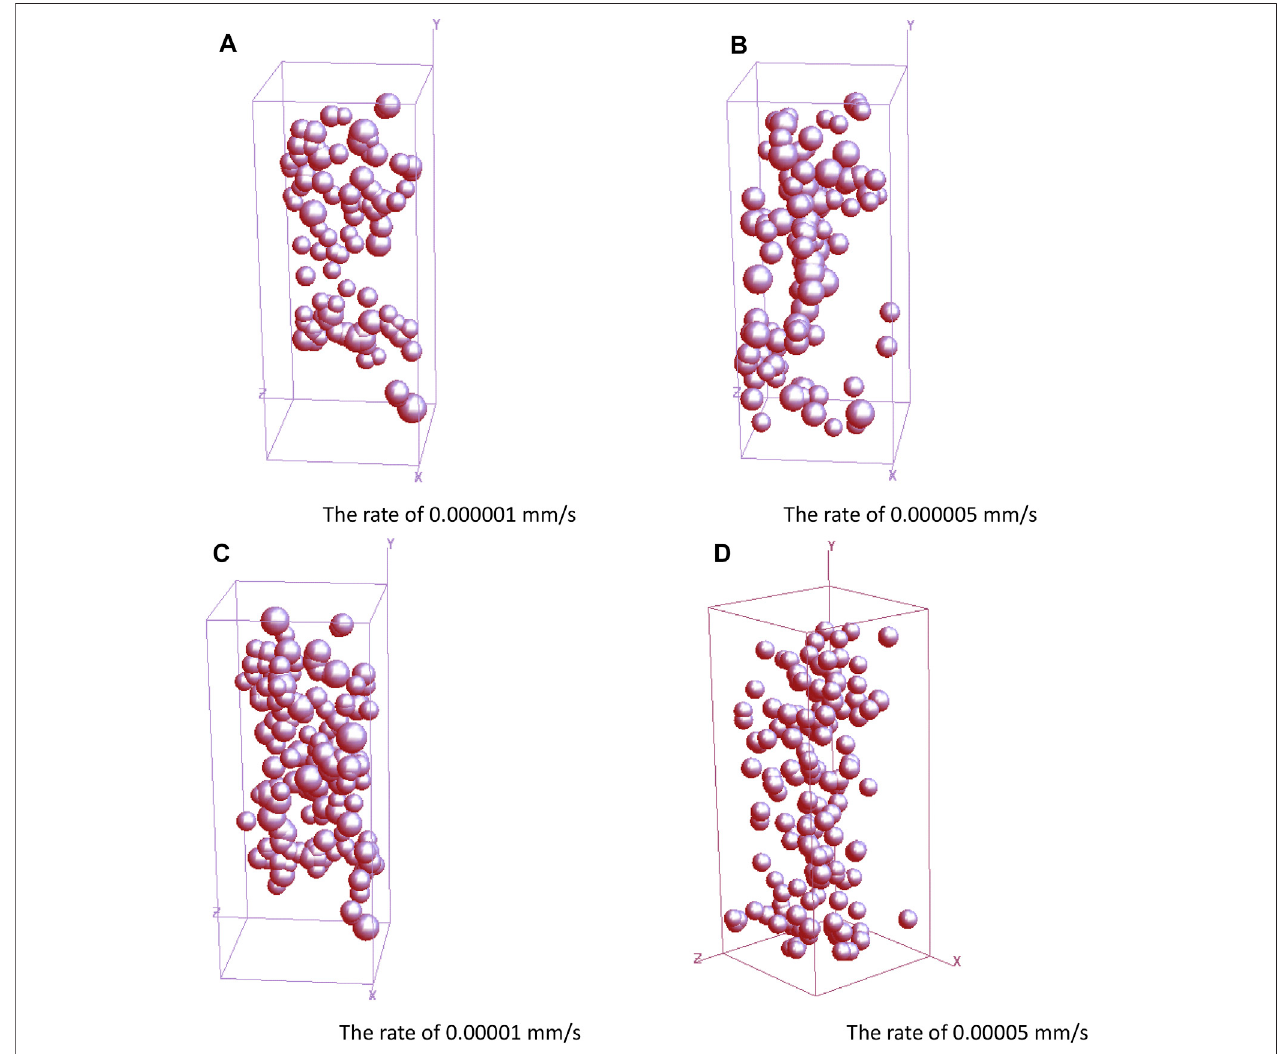
FIGURE 10 | AE failure modes of rock specimens under different con fi ning pressure rates. (A) is the fi nal simulation result of model acoustic emission at the con fi ning pressure rate of 0.000001 mm/s. (B) is the fi nal simulation result of model acoustic emission at the con fi ning pressure rate of 0.000005 mm/s. (C) is the fi nal simulation result of model acoustic emission at the con fi ning pressure rate of 0.00001 mm/s. (D) is the fi nal simulation result of model acoustic emission at the con fi ning pressure rate of 0.00005